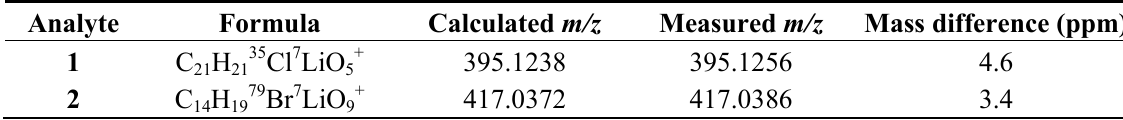
Table 1. The high-resolution measured and calculated masses of [M+Li] + peaks of analytes 1 and 2 .